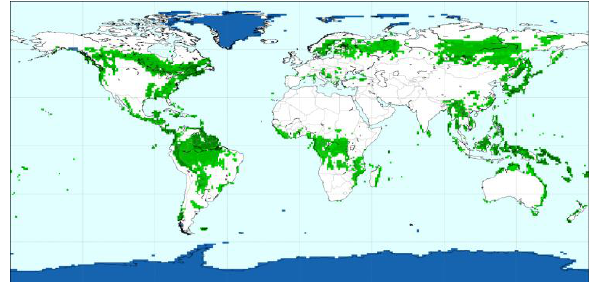
Figure 1: Forest (green) and Ice (Blue) assignment for the Absolute Height Accuracy